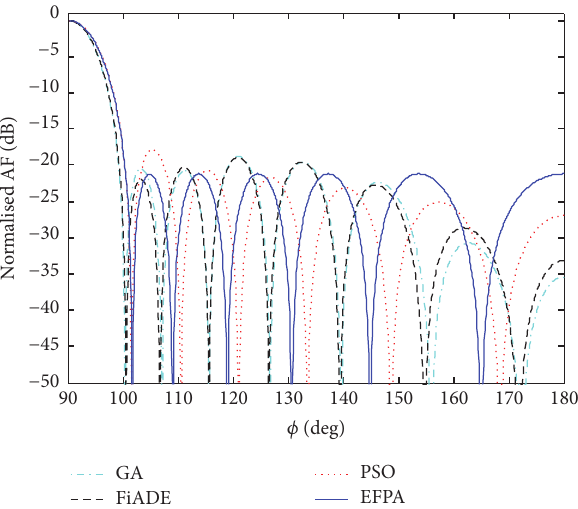
Figure 3: Radiation plot of 12-element EFPA optimized LAA. nonuniform LAA is optimized for SLL reduction in the region 𝜙 ∈ [ 100 ∘ , 180 ∘ ] and having nulls in the directions of 120 ∘ , 122.5 ∘ , and 125 ∘ . The desired beamwidth is set to the value of 8.35 ∘ with tolerance of ±1 ∘ . The optimum